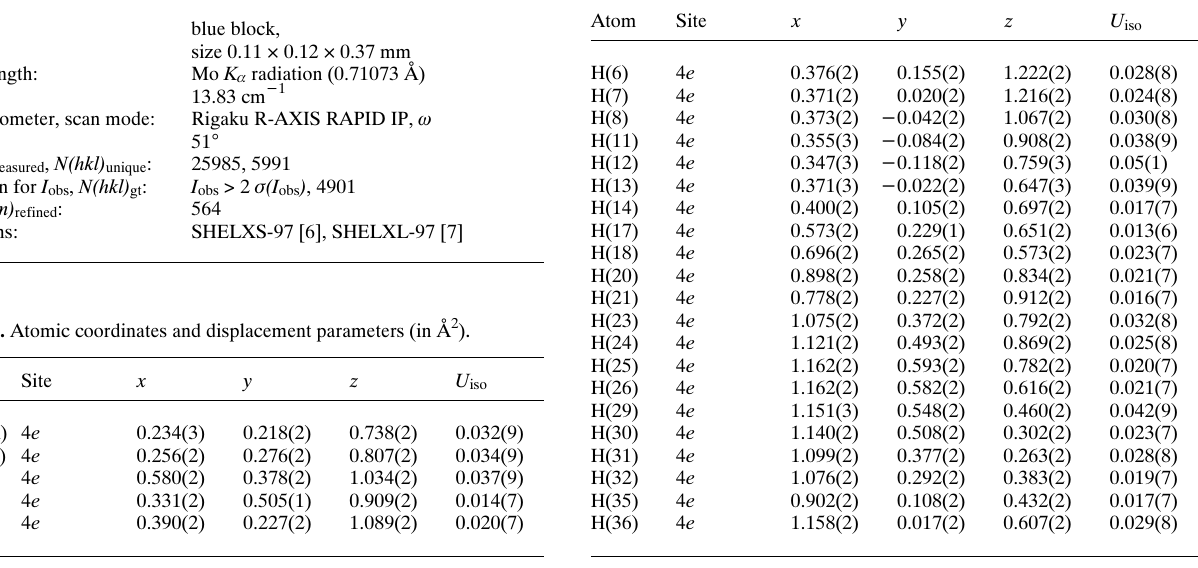
Table 1. Data collection and